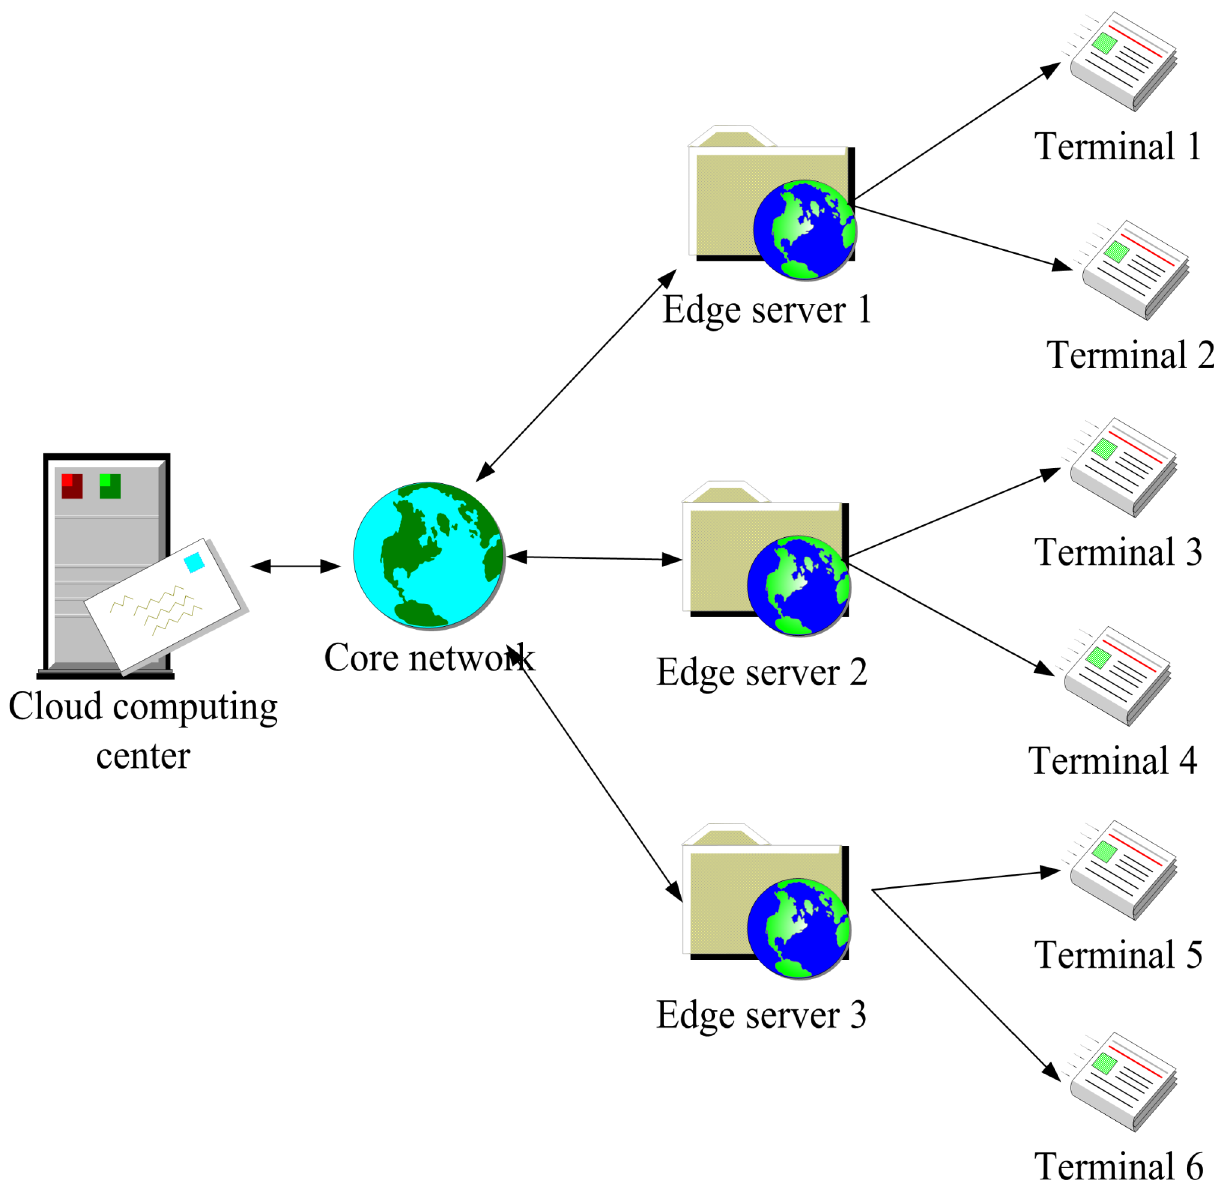
Fig. 5 General architecture diagram of edge